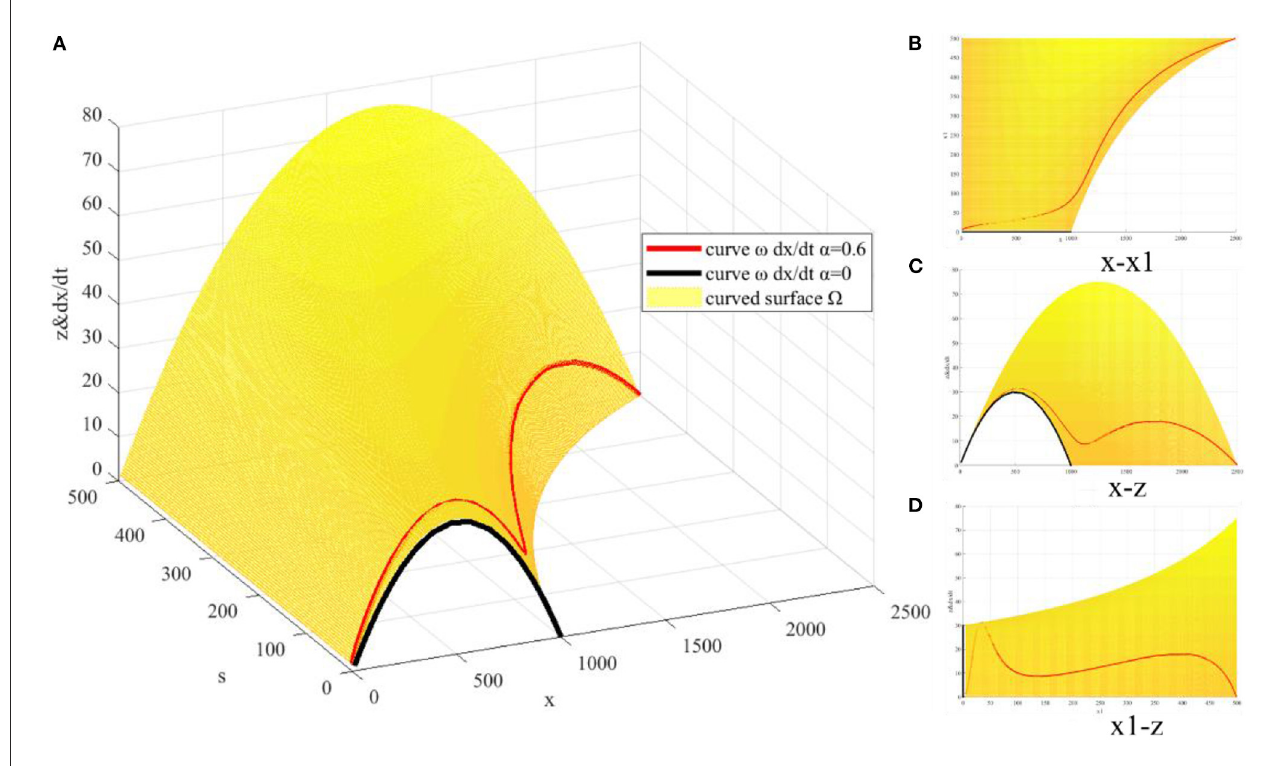
FIGURE4 Model solution x ( t ) and dx dt .